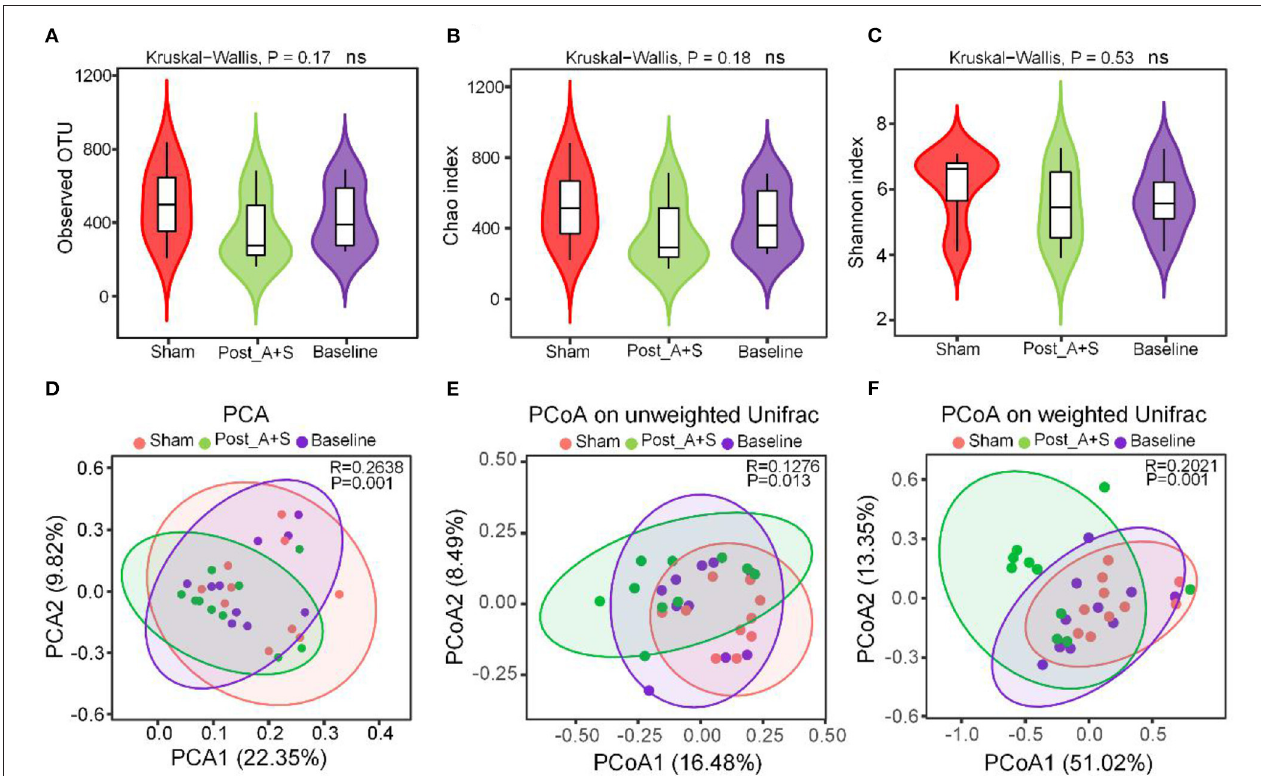
FIGURE 2 | Altered gut microbiota affected by anesthesia/surgery. (A) Operational taxonomic units (OTUs) of microbiota in each sample. (B) Chao 1 index for each sample. (C) Shannon index for each sample. (D) Principal component analysis (PCA) of the three types of fecal samples. (E) PCoA of the unweighted UniFrac of the three types of fecal samples. (F) PCoA of the weighted UniFrac of the three types of fecal samples ( n = 10 for both the sham, baseline, and A + S